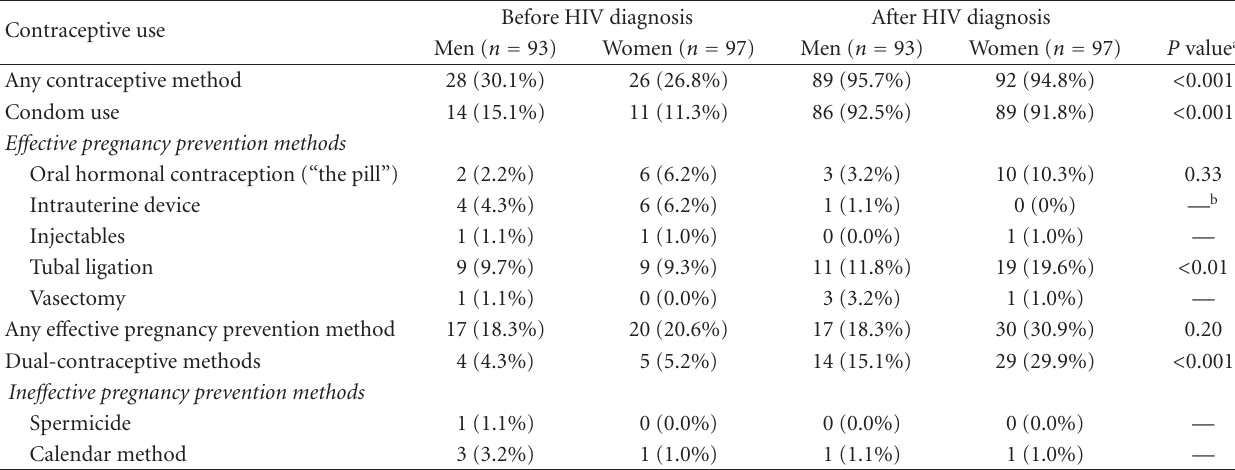
Table 2: Use of contraceptives before and after HIV diagnosis as reported by married persons living with HIV in India. Contraceptive